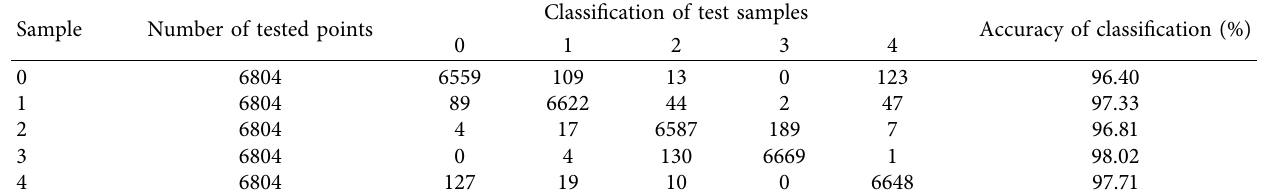
Table 3: Classification results of RF